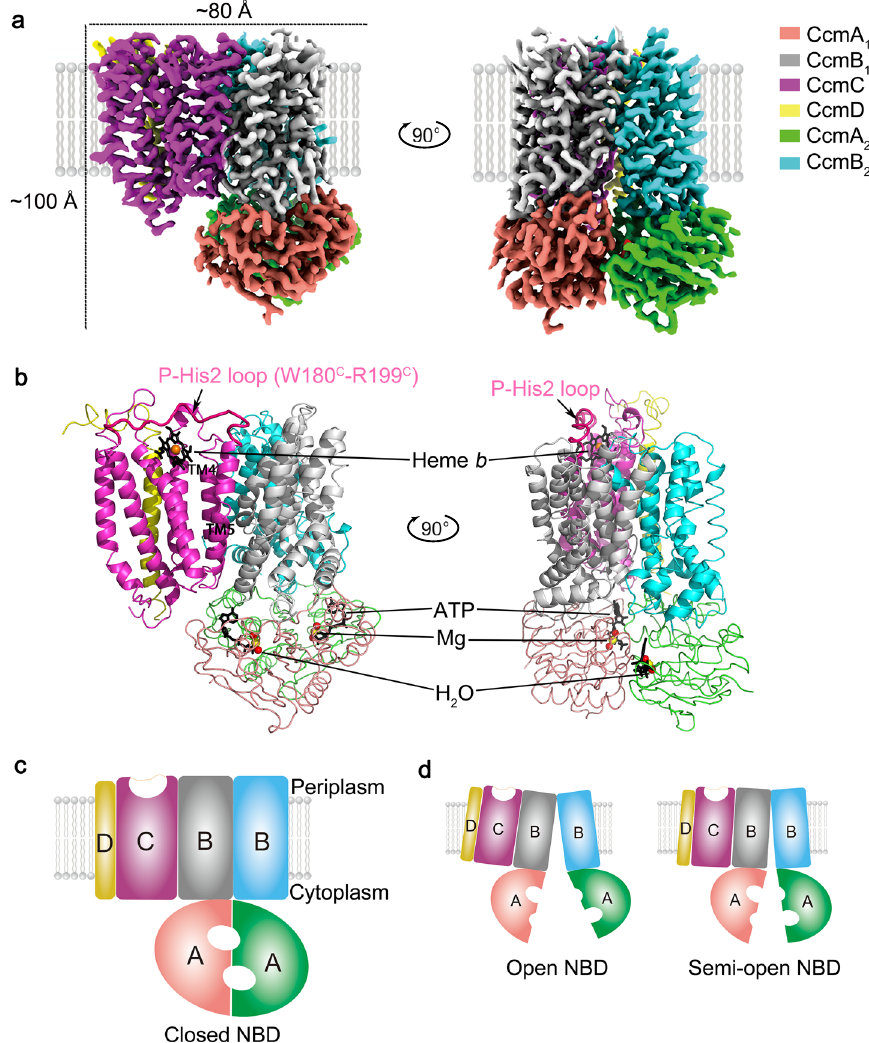
Fig. 1 | Overall structure of the E. coli cytochrome c maturation complex CcmABCD. a The cryo-EM density map of CcmABCD complex bound with heme b and two ATPs in closed NBD state. b Cartoon representation of CcmABCD structure. The bound ATPs and heme b are shown in black stick. The iron atom is